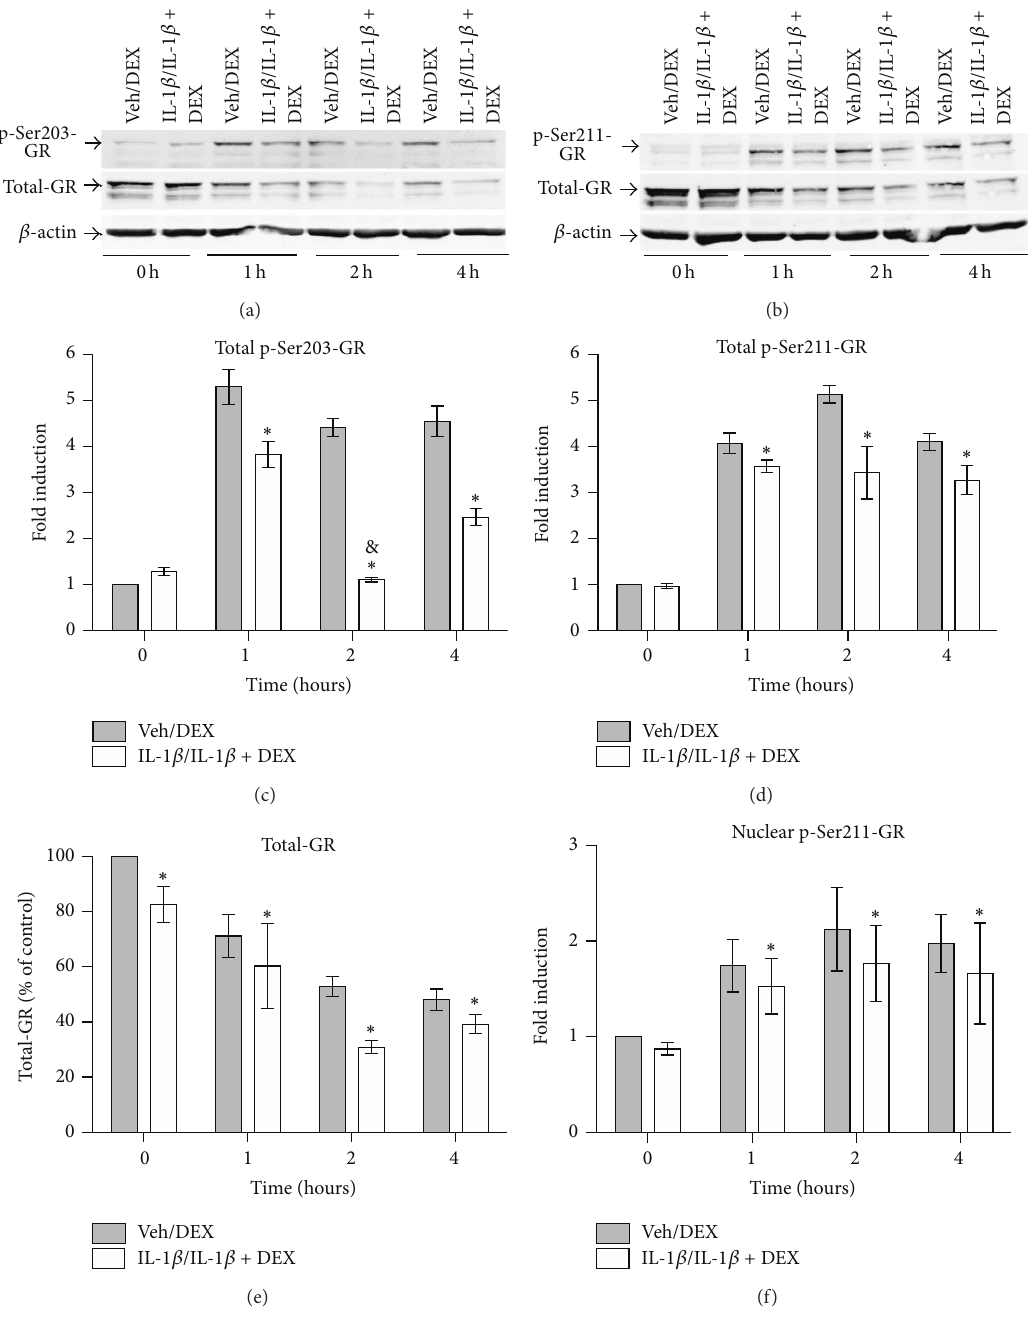
Figure 4: Sustained IL-1 𝛽 conditions reduce the levels of DEX-activated cytoplasmic p-GR Ser 203 and nuclear p-GR Ser 211 . Cells were pretreated with vehicle or 5 ng/mL IL-1 𝛽 for 16h followed by treatment with either 10 −8 M DEX (veh/DEX, (gray column)) or 5 ng/mL IL-1 𝛽 + 10 −8 M DEX (IL-1 𝛽 /IL-1 𝛽 + DEX, (white column)) for 0, 1, 2, or 4h. Whole cell lysates were prepared, normalized for total protein concentration, and tested by Western blot with p-GR Ser 203 -, p-GR Ser 211 -, and total GR-specific antibodies. Anti- 𝛽 -actin was used to confirm that protein load was normalized in each lane before relative quantitation. Blots representative of the p-GR Ser 203 (a) and p-GR Ser 211 (b) analyses ( 𝑛 = 3 ). Quantitation of whole cell p-GR Ser 203 (c), p-GR Ser 211 (d), and total GR (e) protein by densitometry. Data are represented as mean ± SEM. For each condition, bars represent fold-changes in p-GR Ser 203 , p-GR Ser 211 , and GR total at 1, 2, or 4h compared to veh/DEX-treated cells at 0 h. ∗ 𝑃 < 0.05 , differences between sustained IL-1 𝛽 conditions (IL-1 𝛽 /IL-1 𝛽 + DEX, (white column)) and DEX alone-treated cells (veh/DEX, (gray column)). & 𝑃 < 0.05 , differences in p-GR Ser 203 induction between 2 h and 1h post-DEX challenge under sustained IL-1 𝛽 conditions (IL-1 𝛽 /IL-1 𝛽 + DEX, (white column)). (f) HCA microscopy analyses of nuclear p-GR Ser 211 content. Results are expressed as mean ± SEM fold-induction of nuclear p-Ser 211 -GR at 1, 2, or 4h compared to veh/DEX-treated cells at 0h ( 𝑛 = 5 ). ∗ 𝑃 < 0.05 IL-1 𝛽 /IL-1 𝛽 + DEX-treated versus veh/DEX-treated